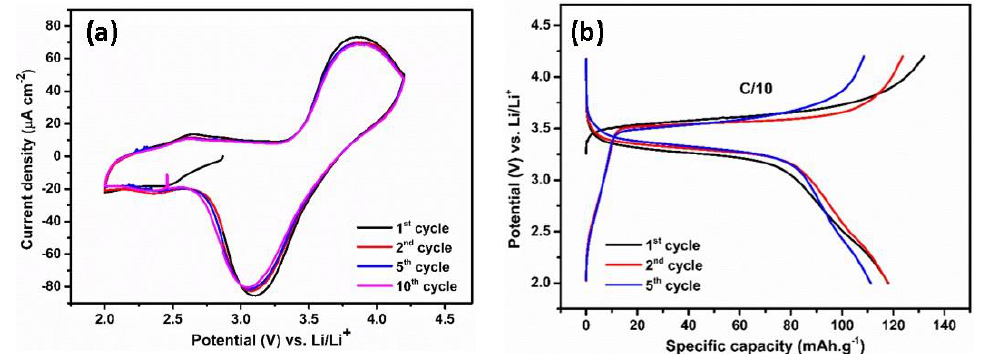
Figure 6. Cyclic voltammogram ( a ) and typical galvanostatic charge/discharge profiles ( b ) of LiFePO 4 at C/10 rate in the potential range of 2–4.2 V vs. Li/Li + .